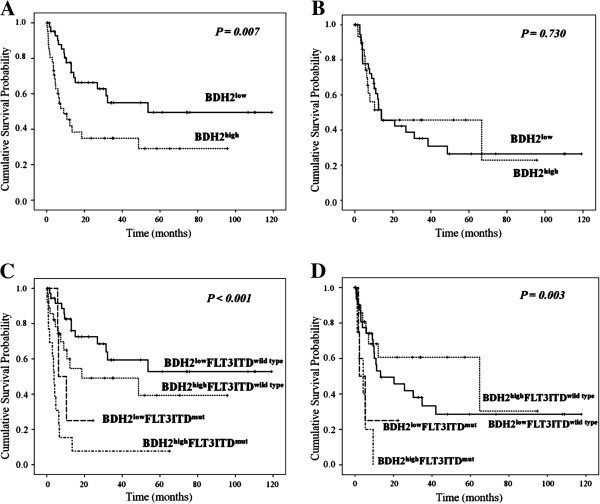
Outcome of patients with CN-AML according to BDH2 expression levels and FLT3-ITD mutation status. In 85 patients receiving intensive induction chemotherapy, we analyzed A) overall survival; B) leukemia-free survival between 2 different BDH2 expression groups; and C) overall survival; D) leukemia-free survival between groups differentiated by BDH2 expression level, combined with the FLT3-ITD mutation status.